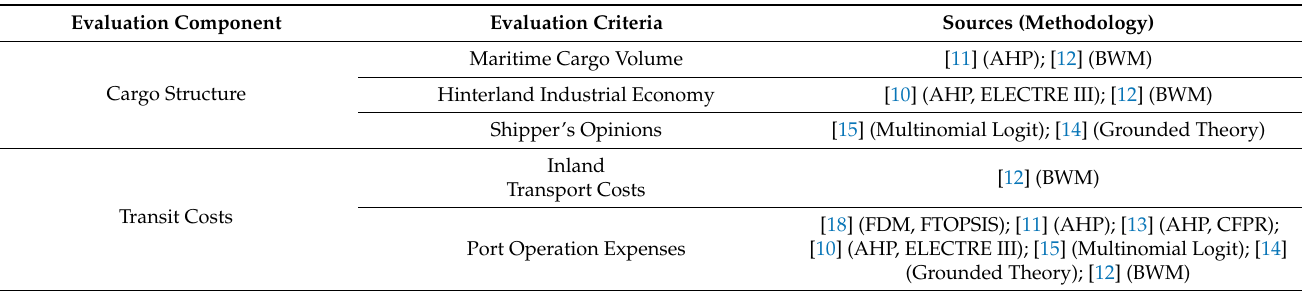
Table 2. Evaluation criteria of the best alternatives for the development of international crew change transit centers in Taiwanese